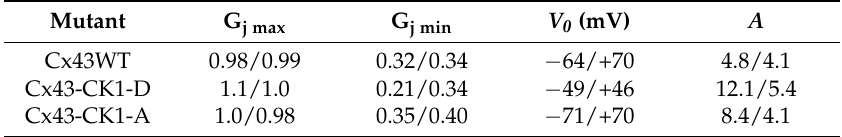
Table 1. Boltzmann parameters of Cx43 WT and